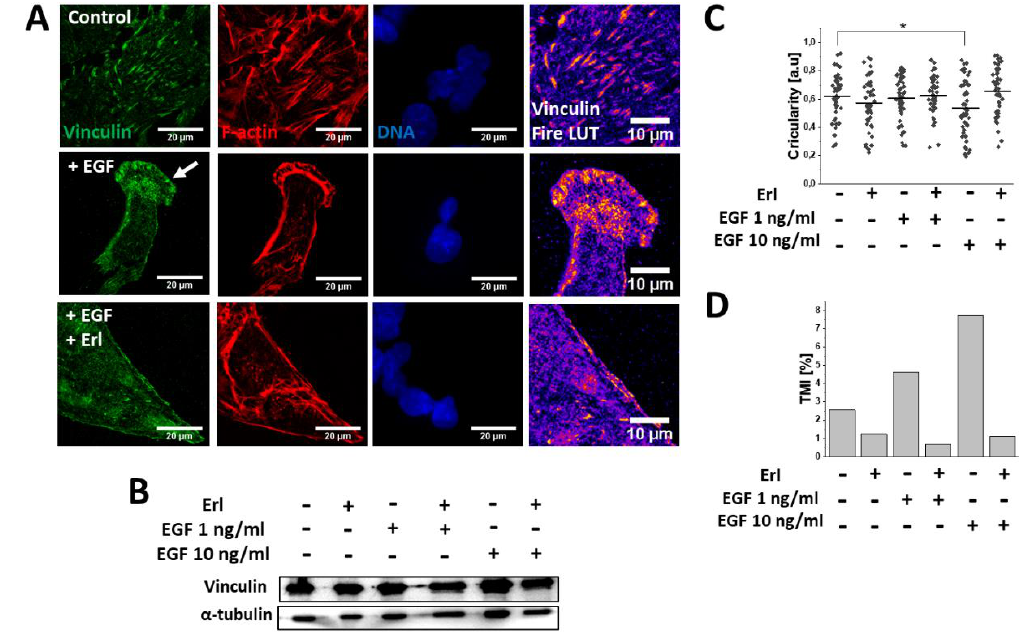
Figure 4. EGF (10 ng / mL; 72 h) promoted F-actin- / vinculin-related cytoskeletal rearrangements within GBM cells. ( A ) Visualization of EGF-dependent F-actin remodeling accompanied by vinculin redistribution towards the leading edges of GBM cells. Fire LUT mask depicts accumulation of vinculin within cellular compartments (blue: low level, yellow / orange: high level). ( B ) Western blot examination of total intracellular vinculin content changes in GBM cells during EGFR signaling modulation. α -tubulin was detected as a reference protein. ( C ) EGF promoted transition towards mesenchymal (spindle-like; lower circularity) morphology in a dose-dependent manner. ( D ) EGF augmented the transmigration potential of GBM cells (expressed as TMI (transmigration index)) in in vitro Transwell ® assay. Note that EGF exerted negligible e ff ects on vinculin level changes but prominently enhanced invasive properties of GBM cells. n = 40 cells. Statistical significance was calculated with non-parametric Mann–Whitney test, * p < 0.05 vs. control.